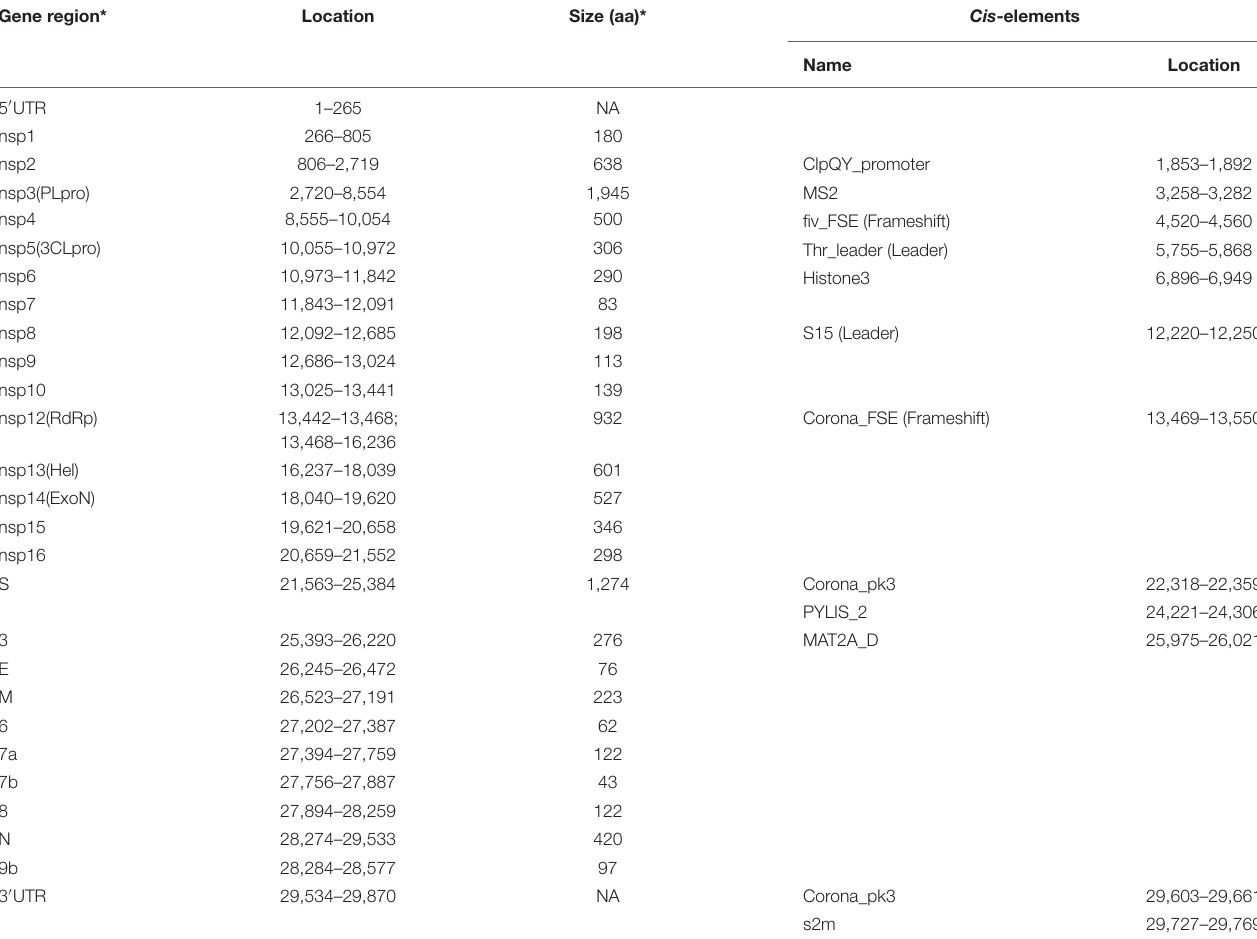
TABLE 3 | Location and size of the putative gene, proteins, cis-elements of SARS-CoV-2 (EPI_ISL_402123). Gene region* Location Size (aa)* Cis